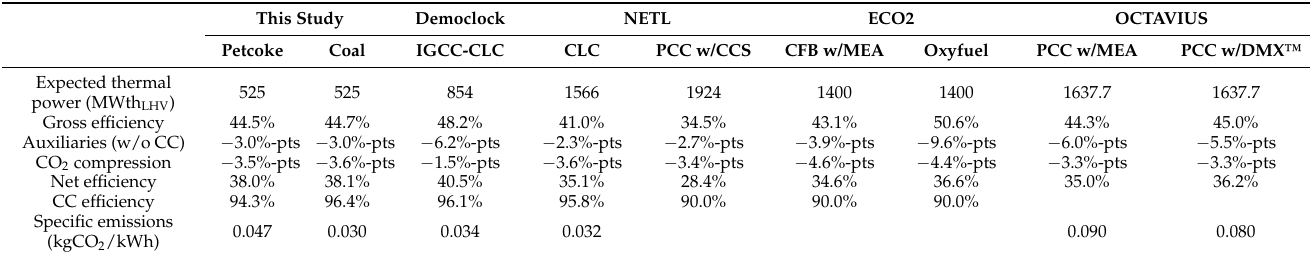
Table 9. Resulting energy balance comparison with other coal-fueled processes: Democlock [68], NETL [69], ECO2 [70], and OCTAVIUS [71]. The OCTAVIUS energy balance has been rearranged to comply with the other